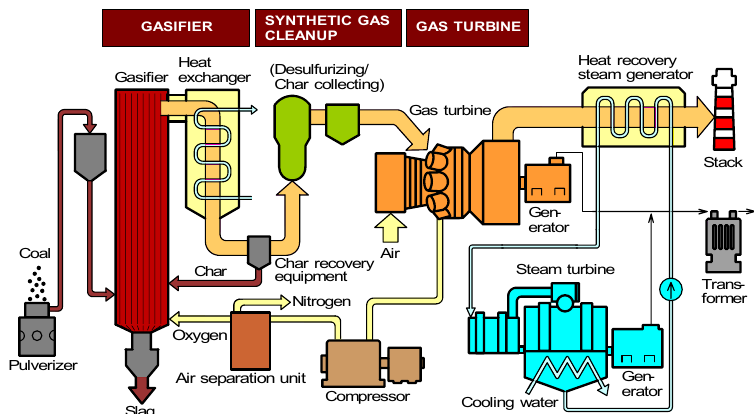
Figure 5. Schematic diagram of typical IGCC